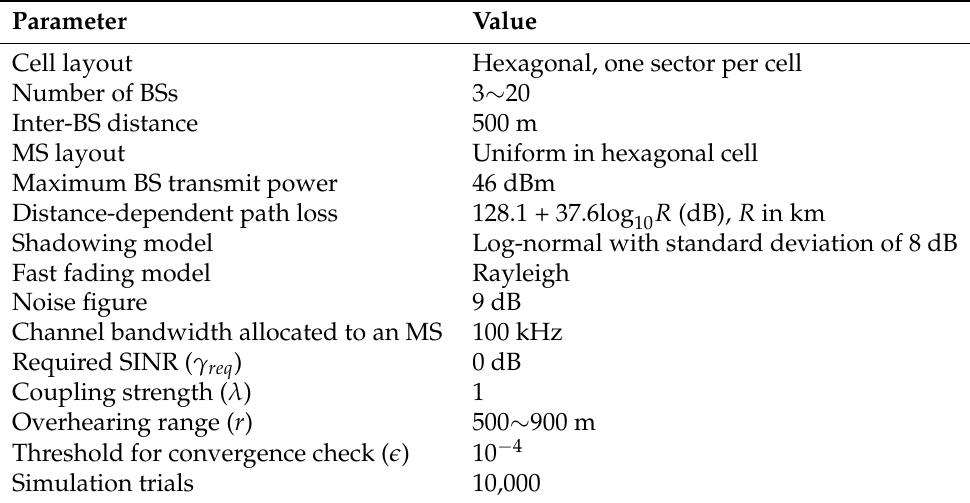
Table 1. Parameter setup. MS, mobile